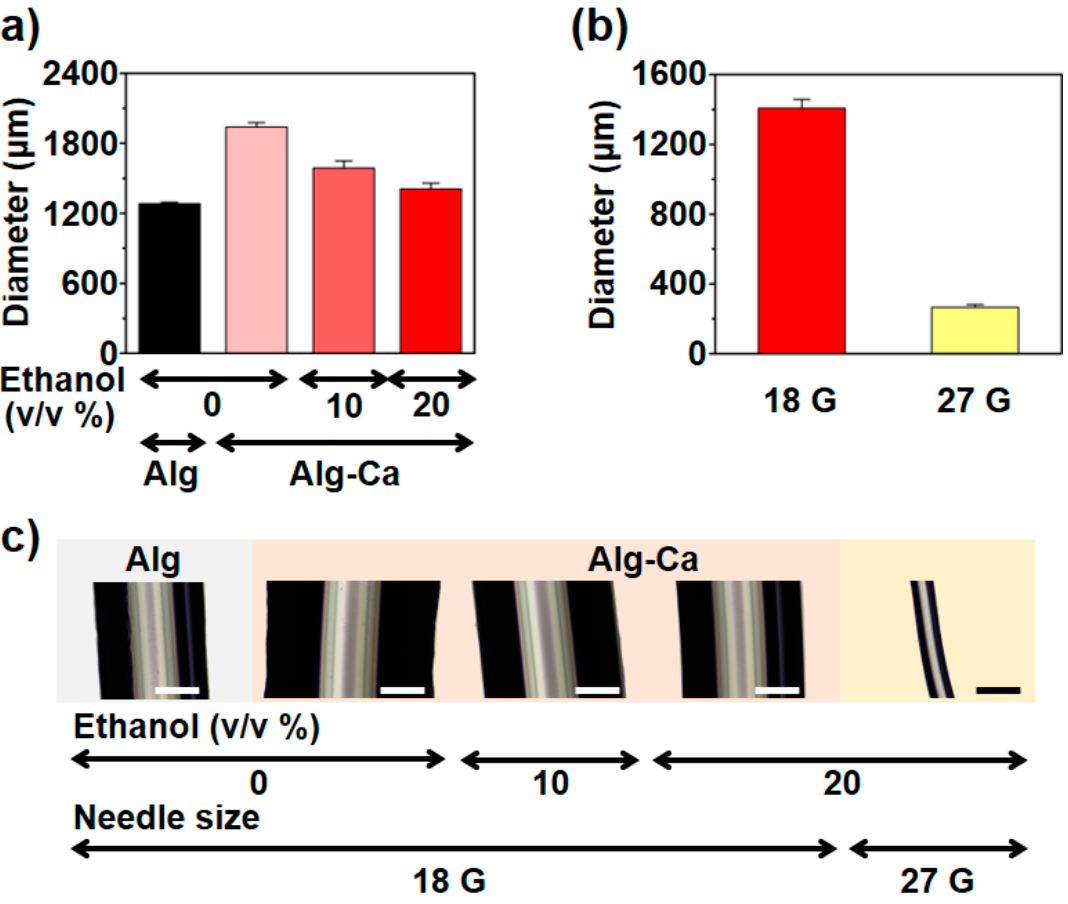
Figure 3. Initial diameter of Alg-Ca fibers depending on wet-spinning condition. ( a ) Initial diameter of Alg fiber (first bar) and Alg-Ca fiber (second–fourth bar) depending on ethanol concentration of CaCl 2 solution ( n = 3, mean ± SD). ( b ) Initial diameter of Alg-Ca fiber fabricated with 20% ( v / v ) ethanol CaCl 2 solution using 18 G (red) and 27 G (yellow) blunt needle ( n = 3, mean ± SD). ( c ) Representative images of Alg (first) and Alg-Ca (second—fifth) fibers (scale bar = 500 µ m).